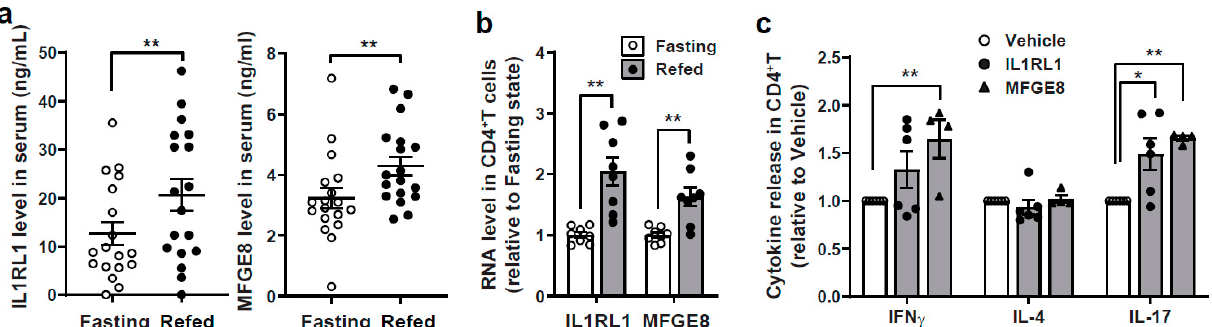
Figure 5. Integrating SomaLogic and RNAseq data. ( a ) Verify the SOMAscan results of IL1RL1 and MFGE8 by ELISA using serum collected from three metabolic conditions ( n = 18). Paired t -test; ** p < 0.01. ( b ) RNA expression level in CD4 + T cells ( n = 4–6). Unpaired t -test; ** p < 0.01. ( c ) Cytokine release after treatment of recombinant proteins (24 h) in CD4 + T cells followed by aCD3/aCD28 activation for 3 days ( n = 4–6). Unpaired t -test; * p value < 0.05; ** p < 0.01. IL1RL1, Interleukin 1 receptor like-1; MFGE8, Milk fat globule EGF/factor VIII.